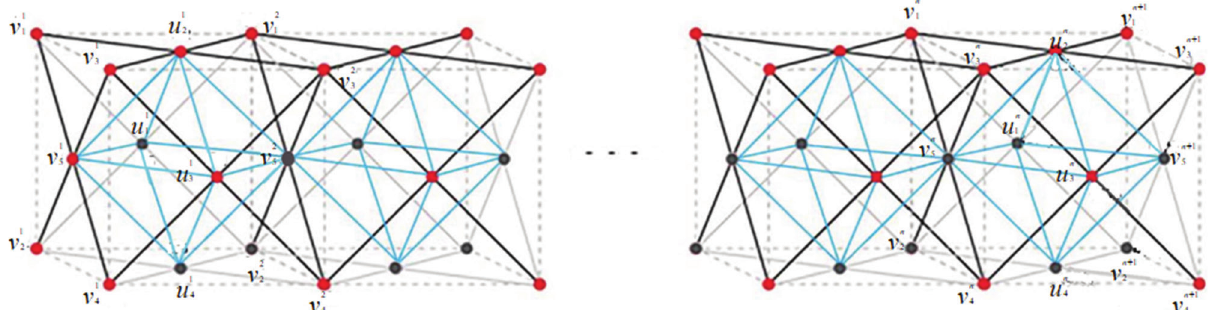
Figure 2: FFC ( n ): row of n unit cells of face-centered cubic ( FCC ) lattice. packing density in 3D space. Because of its largest packing density, FFC is one of the most well-organized structures to pack same size of spheres in a volume. FFC structure is also known as cubic closest-packed crystal